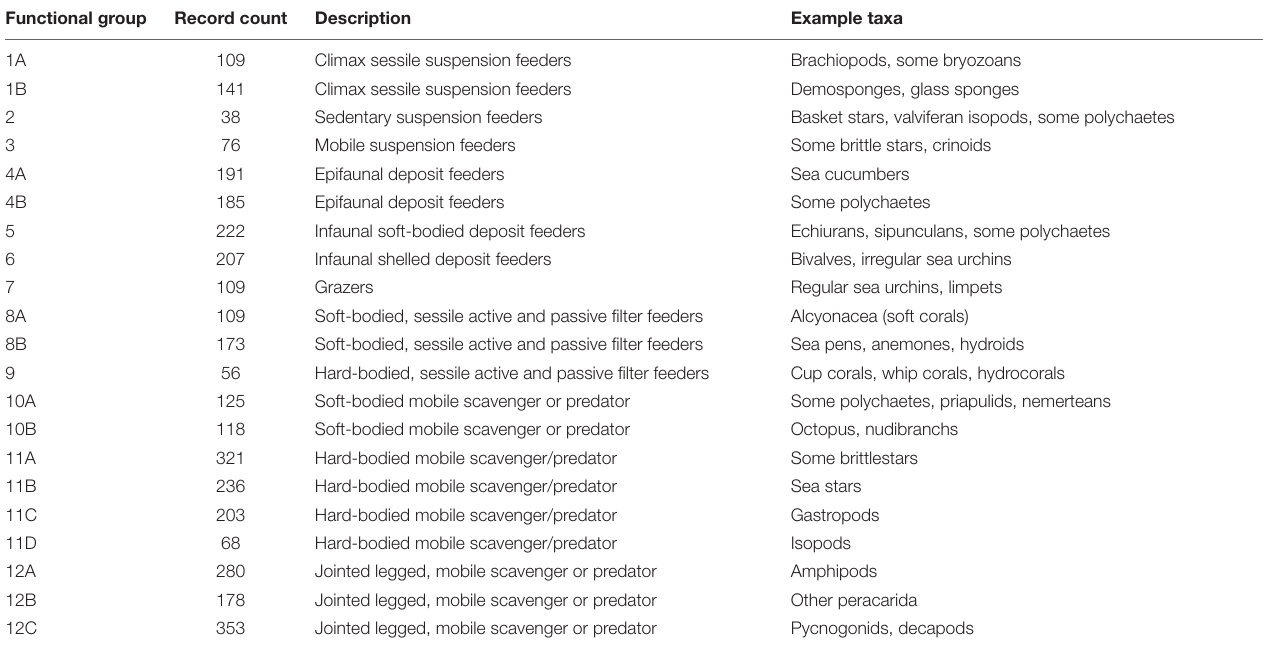
TABLE 1 | Functional group categories modelled using gradient forest analysis. Functional